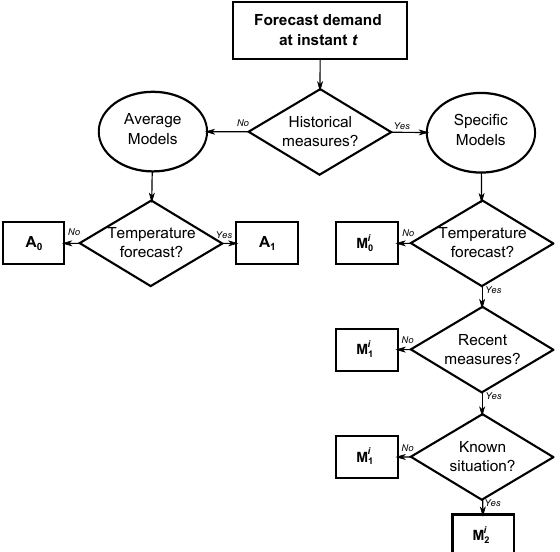
Figure 3. Flowchart of the hierarchical framework indicating which forecasting model is